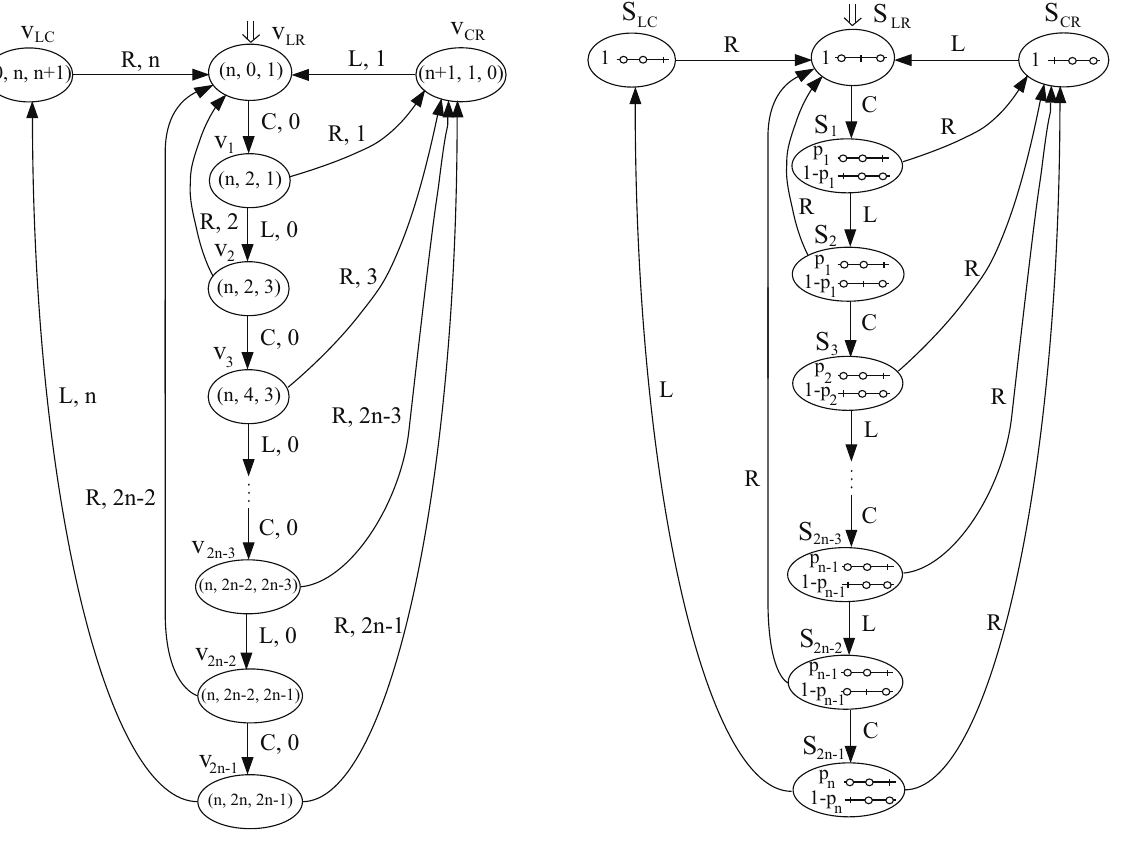
Figure 3 . Offset graph